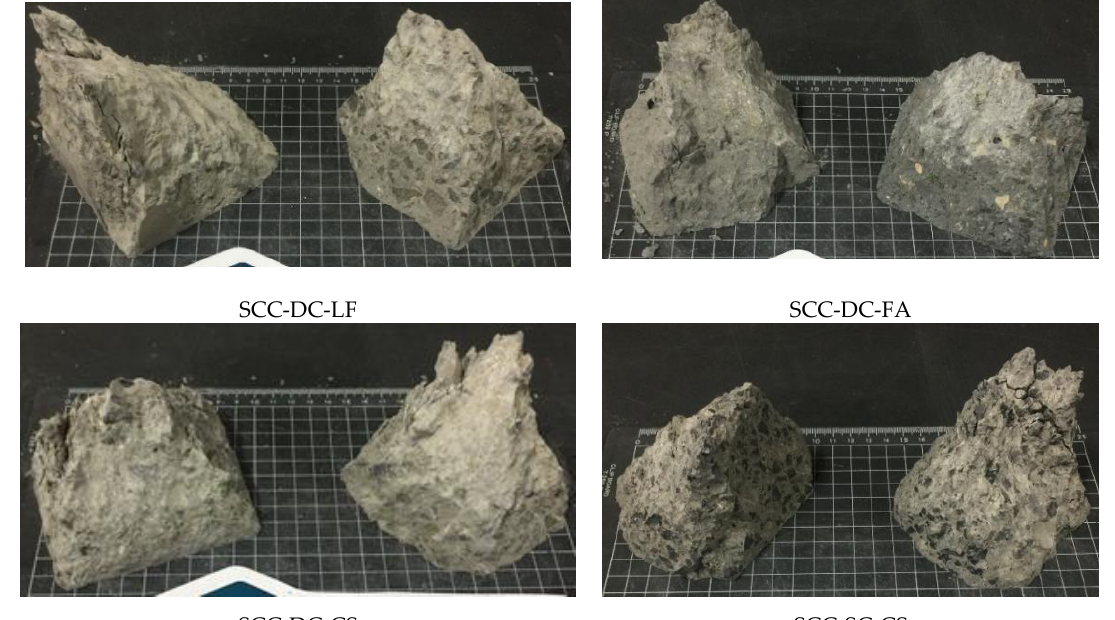
Figure 7. Detail of the compressive strength cracking (365 days).